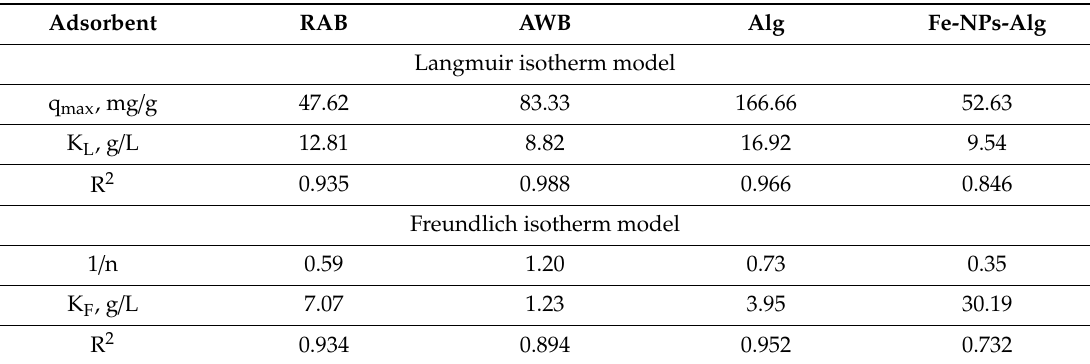
Table 3. Isotherm parameters for Cu(II) ions adsorption on considered adsorbent materials. Adsorbent RAB AWB Alg Fe-NPs-Alg Langmuir isotherm